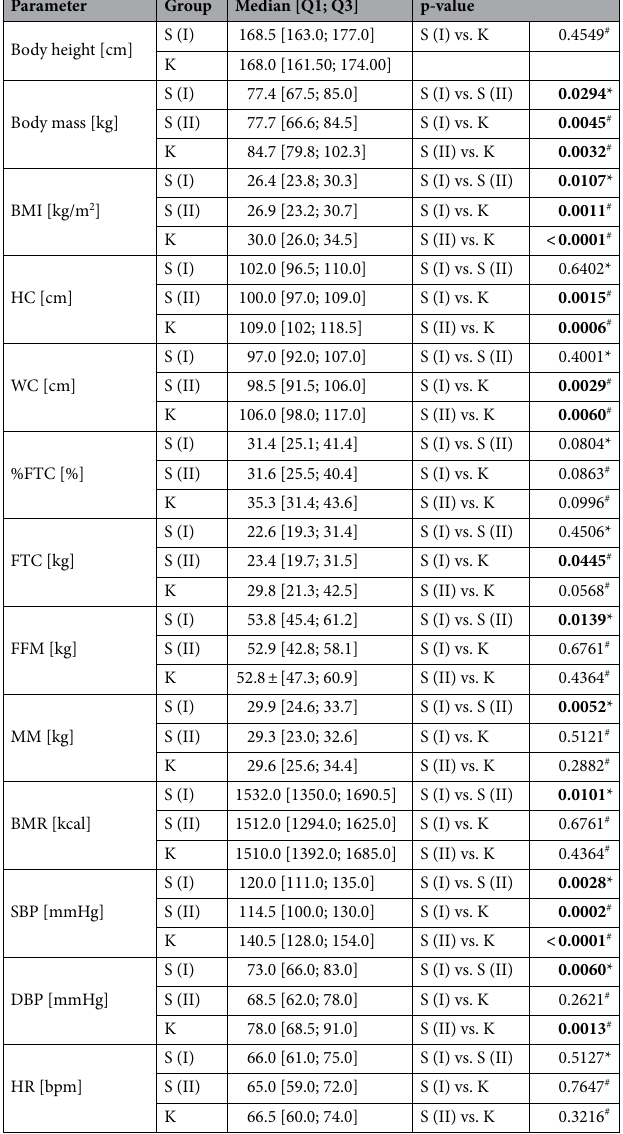
basal metabolic rate; bpm: beats per minute; DBP: resting diastolic blood pressure; FFM: fat-free mass; FTC: mass fat tissue content; HC: hip circumference; HR: resting heart rate; MM: muscle mass; Q1: first quartile; Q3: third quartile; SBP: resting systolic blood pressure; WC: waist circumference. (I): value before intervention; (II): value after the intervention. *Wilcoxon test; # Mann–Whitney test. Significant values are given in